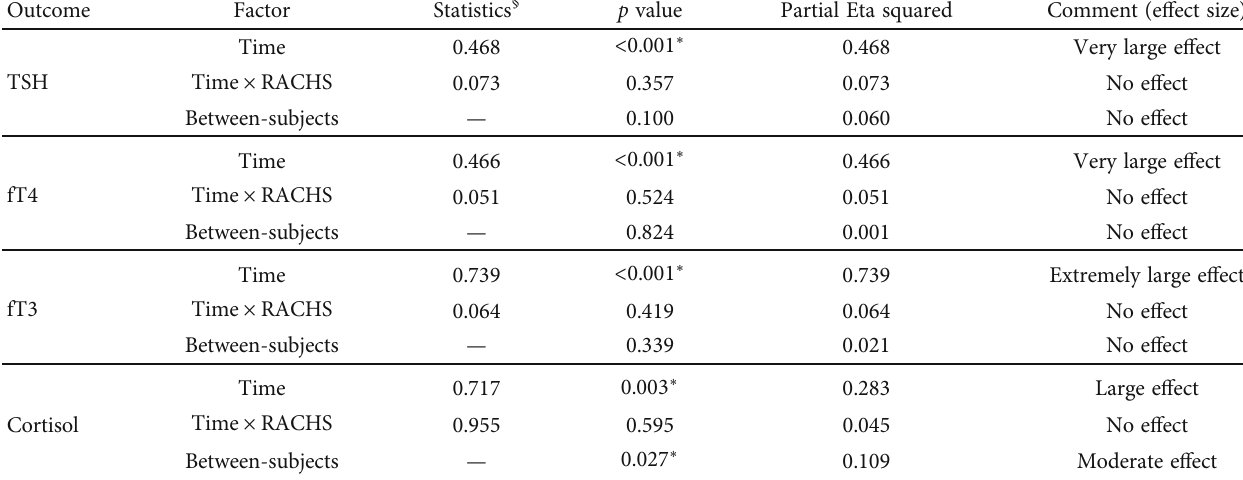
Table 3: E ff ect of cardiac risk category on changes in thyroid function and cortisol levels (Repeated-Measure Analysis of Variance (RM-